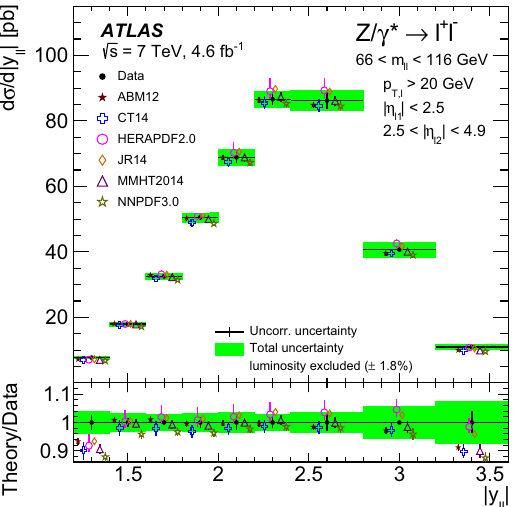
Fig. 23 Differential cross-section measurement d σ/ d | y (cid:3)(cid:3) | for Z /γ ∗ → (cid:3)(cid:3) in the Z -peak region, 66 < m (cid:3)(cid:3) < 116 GeV, for central ( left ) and forward rapidity values ( right ). Predictions computed at NNLO QCD with NLO EW corrections using various PDF sets ( open symbols ) are compared to the data ( full points ). The ratio of